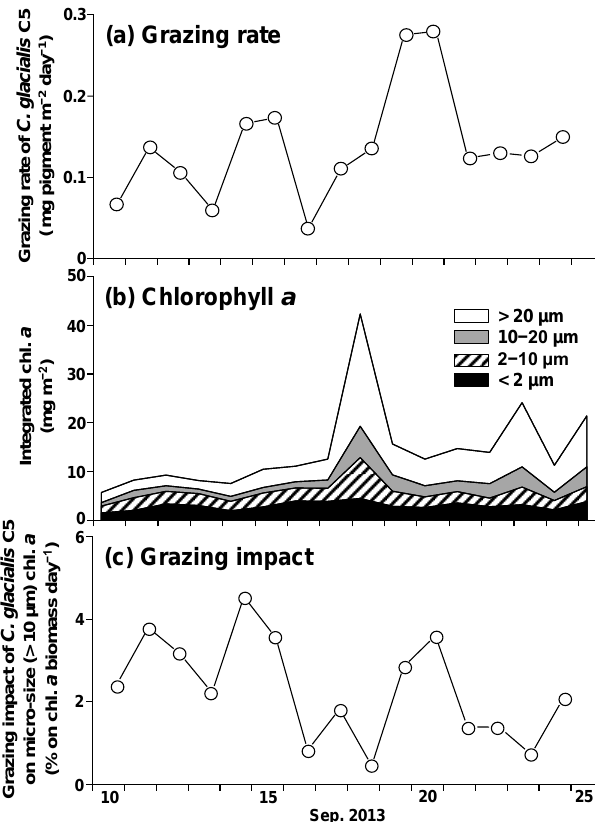
Figure 6. Temporal changes in the grazing rate of Calanus glacialis C5 (a) , integrated size-fractionated chlorophyll a (b) and grazing impact of C. glacialis C5 on micro-phytoplankton ( > 10µm) (c) at a fixed station in the Chukchi Sea from 10 to 25 September Fig. 6. (Matsuno et al.)